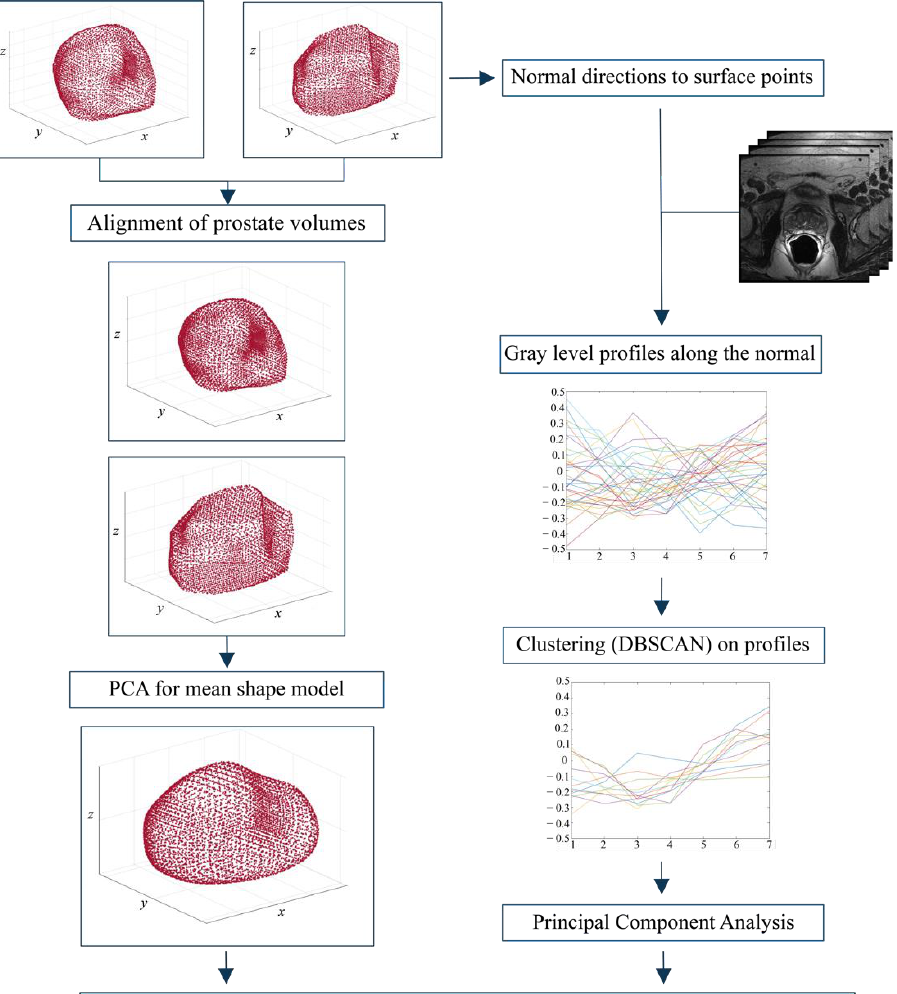
Figure 4. Steps followed to create (i) the average prostate shape model and (ii) the appearance of gray levels used to optimize the prostate contour. The mean shape model is calculated by applying the principal component analysis (PCA) after realigning all volumes in the training set (36 patients). On the other hand, the gray level profiles of the original images are used to construct the grayscale appearance model.